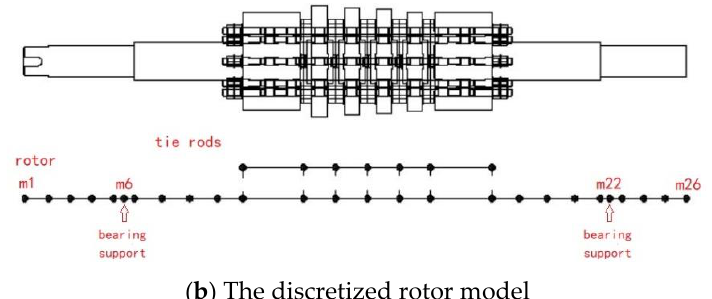
Figure 11. The rotor model.